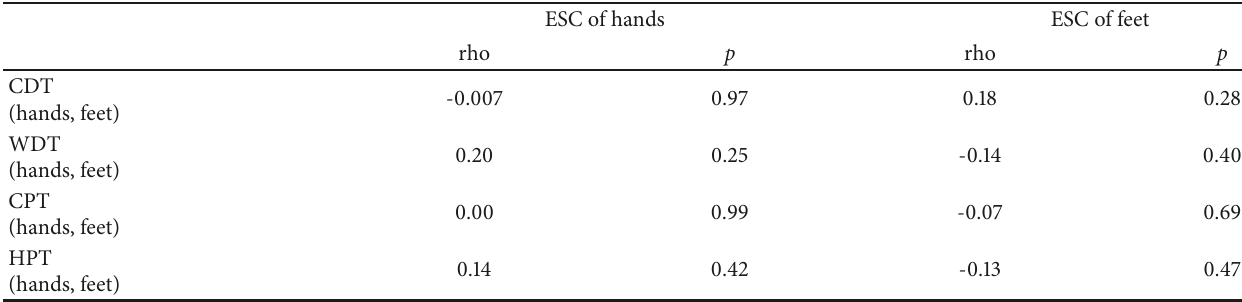
Table 4: Matrices of correlation crossing ESC values and thermal thresholds. Spearman tests were performed. CDT, WDT: Cold and Warm Detection Thresholds. CPT, HPT: Cold and Heat Pain Thresholds. ESC: Electrochemical Skin Conductance. ESC of